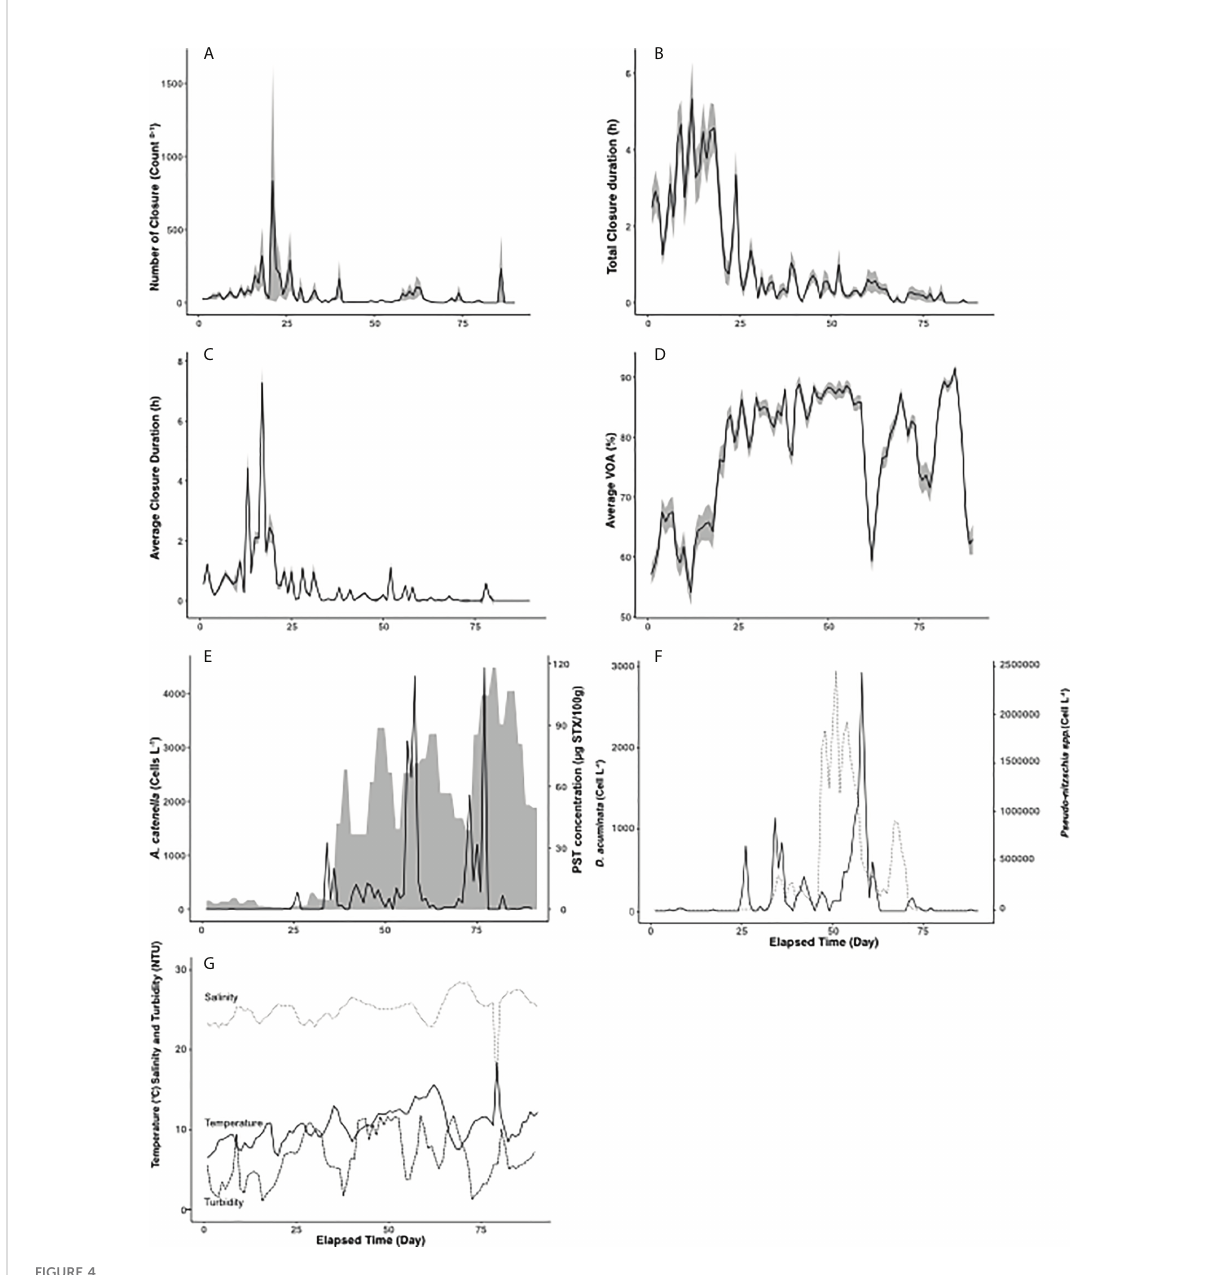
FIGURE 4 Mussel gaping metrics and corresponding standard errors associated to running daily means (shaded areas) over the course of the 90-d experiment in natural seawater for (A) : NC - Number of Closures (Count day -1 ), (B) : TCD - Total Closure Duration (hour), (C) : ACD - Average Closure Duration (hour), and (D) : AVOA - Average Valve Open Amplitude (%). (E) : A. catenella abundance (cells litre -1 ; solid line) in seawater and PST concentration in mussels from the shore (µg STXeq. 100g -1 ; shaded area). (F) : D. acuminate (cells litre -1 ; solid line) and Pseudo-nitzschia spp. (cells litre -1 ; dotted line) abundances in seawater. (G) : Temperature (°C; solid line), Salinity (dotted line) and Turbidity (broken